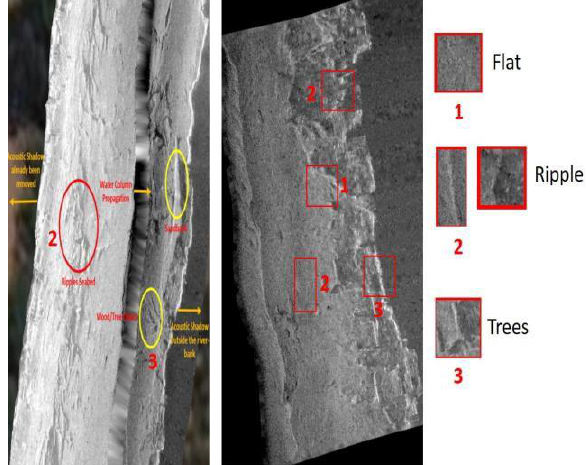
Figure 2. SSS mosaic and some riverbed substrates used in the textural and histogram